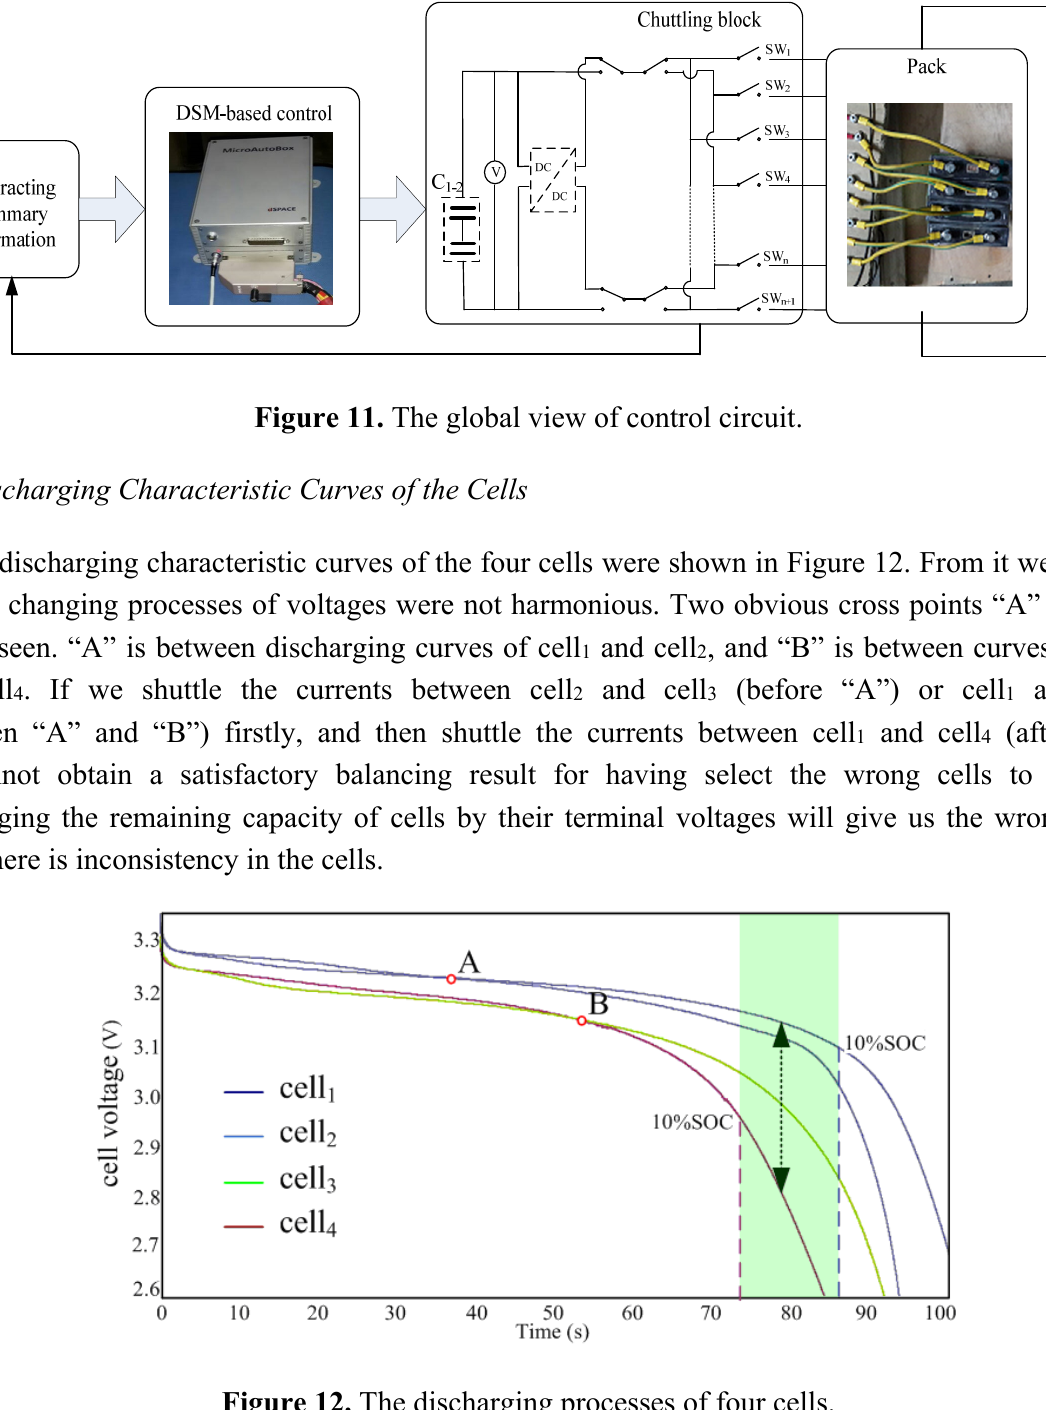
Figure 12. The discharging processes of four